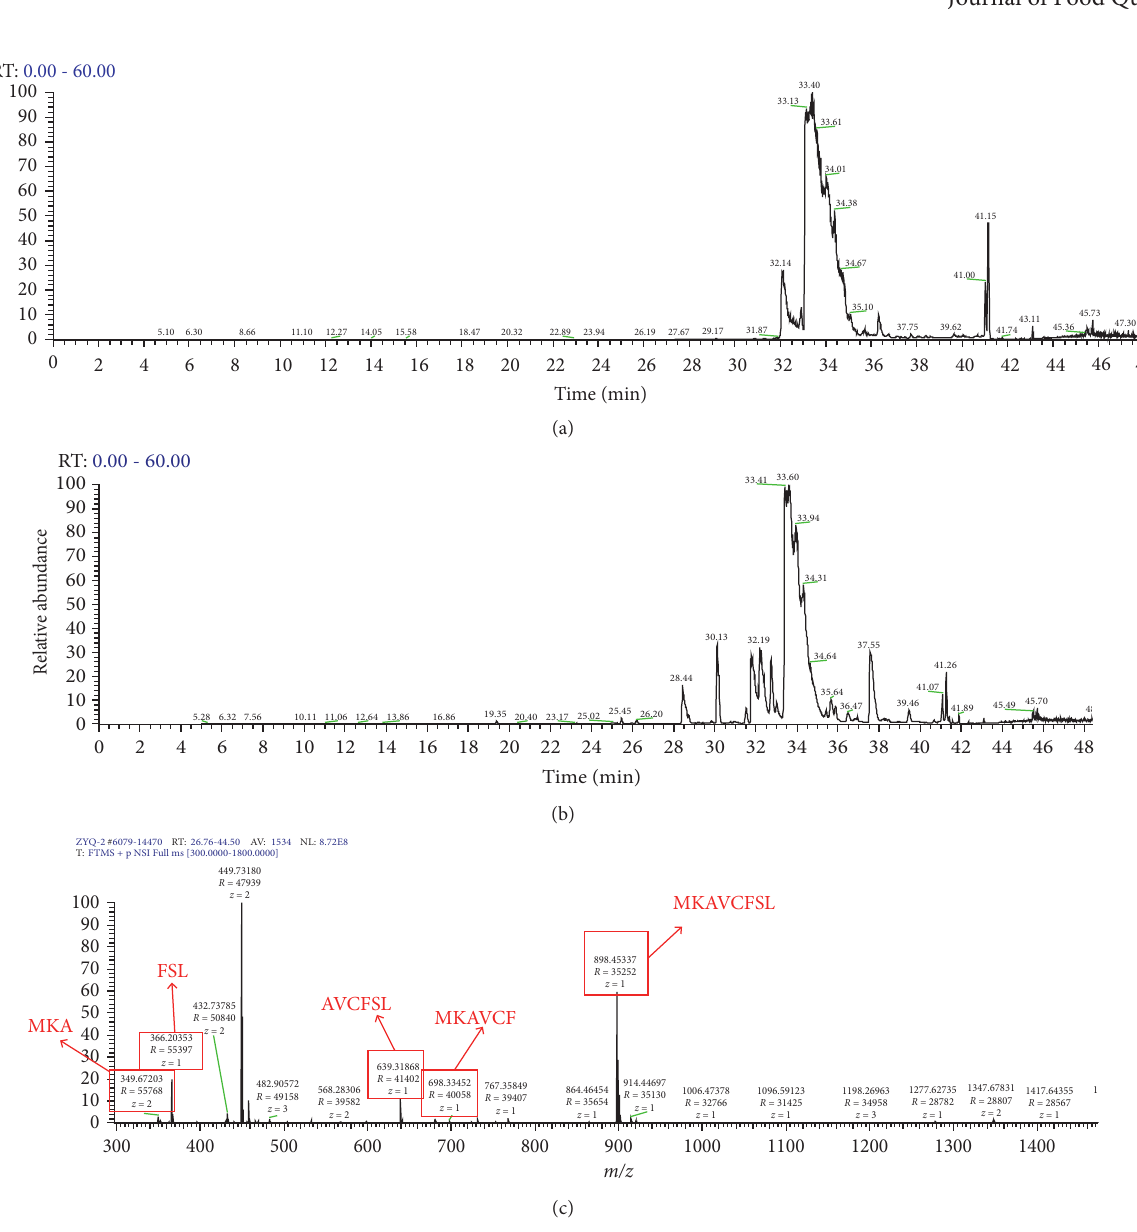
Figure 1: RP-HPLC and LC-MS/MS analysis of MKAVCFSL after simulated gastrointestinal digestion. (a) RP-HPLC chromatogram of undigested MKAVCFSL. (b) RP-HPLC chromatogram of MKAVCFSL after pepsin-pancreatin digestion. (c) LC-MS/MS identification of pepsin-precretin digested